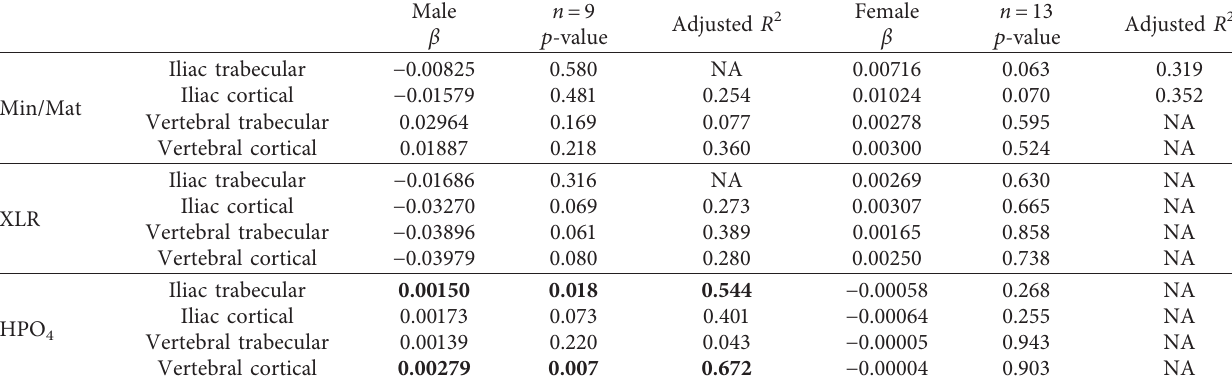
Table 5: The results of multivariate analyses with age